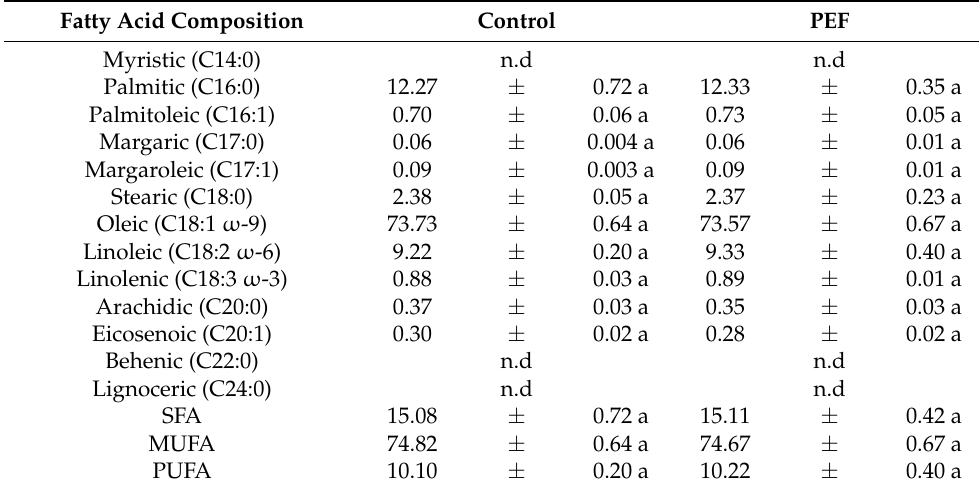
Table 3. Fatty acid composition (%) of